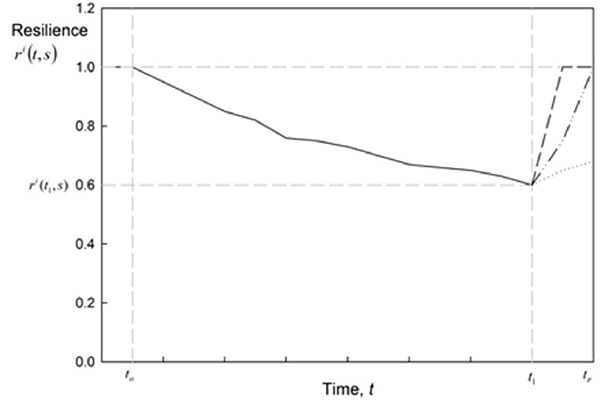
Figure 2. System